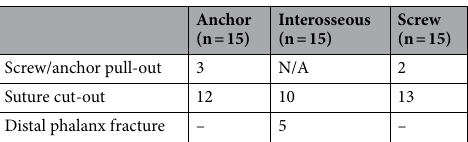
Table 2. Mechanisms of failure after continuous increase of